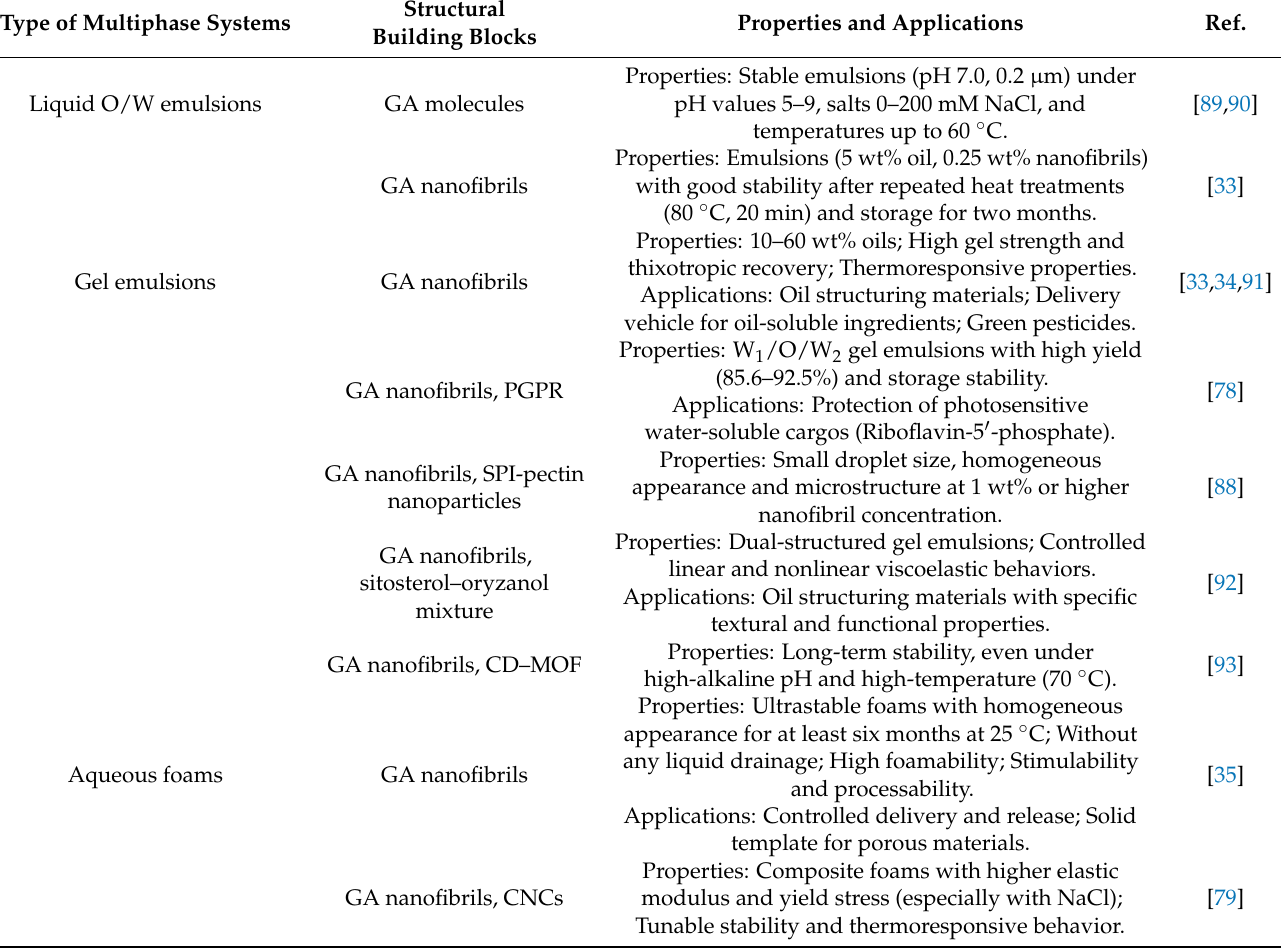
Table 2. Overview of applications of glycyrrhizic acid (GA) and GA nanofibrils in colloidal multiphase food systems. Type of Multiphase